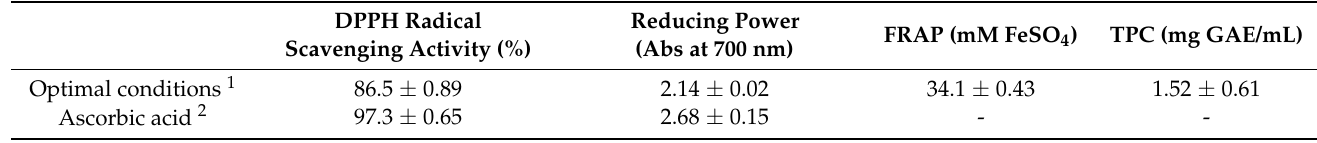
Table 5. Antioxidant activities and TPC of fermented A. capillaris under optimal conditions. DPPH